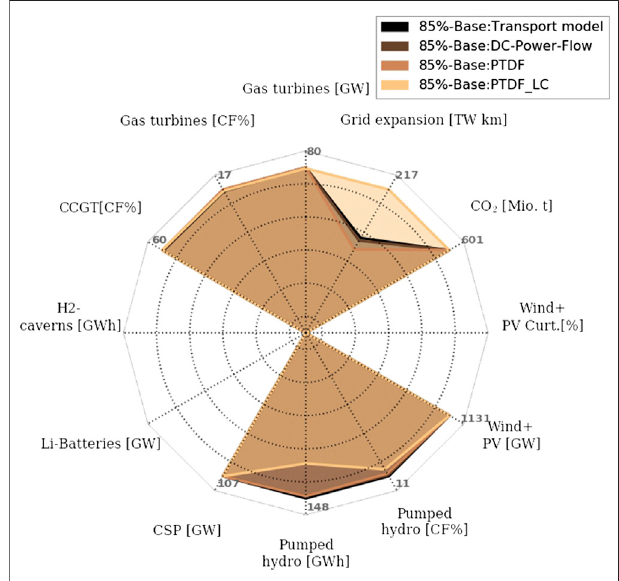
FIGURE 7 | Key indicators comparing 85% Base scenarios using different approaches for modeling power fl